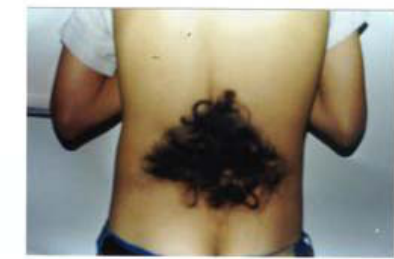
FIGURE 1. A congenital hairy patch over the lumbar skin of the patient.